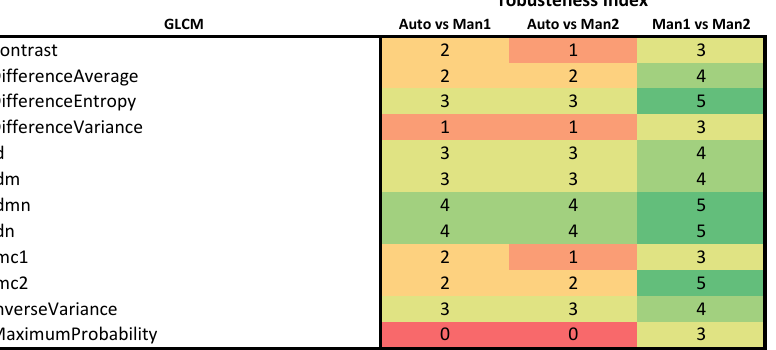
Figure 7. Robustness of the GLCM radiomic features obtained on DCE-MRI images using automated segmentation against two manual segmentations from two independent readers.